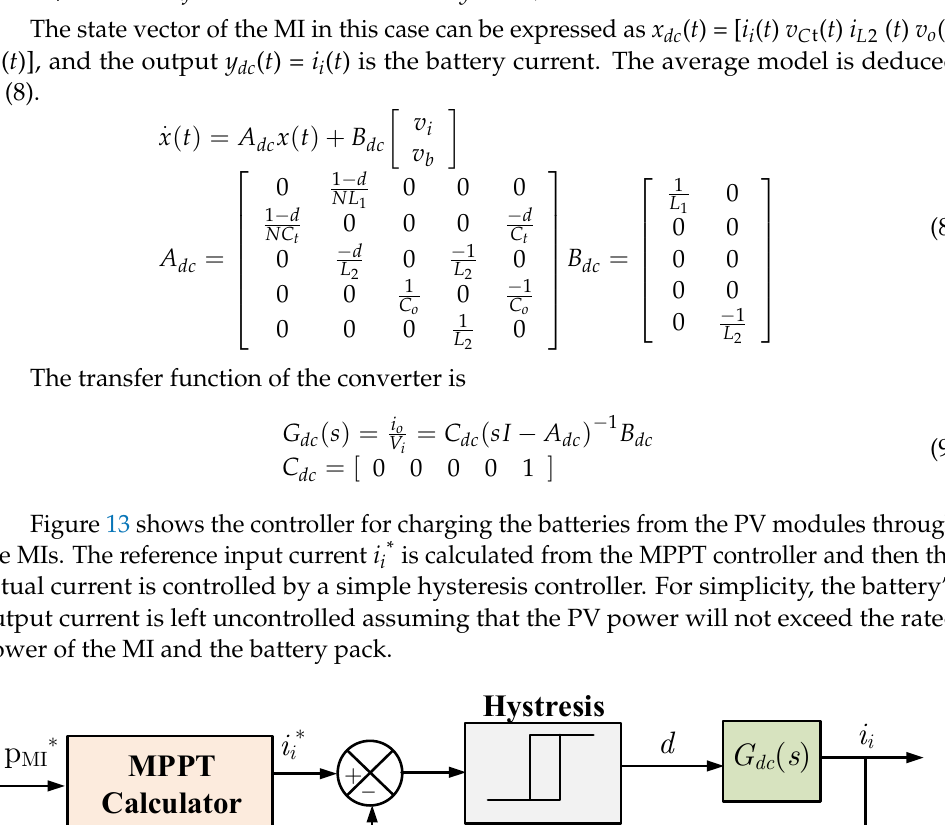
Figure 14. MCI experimental prototype.